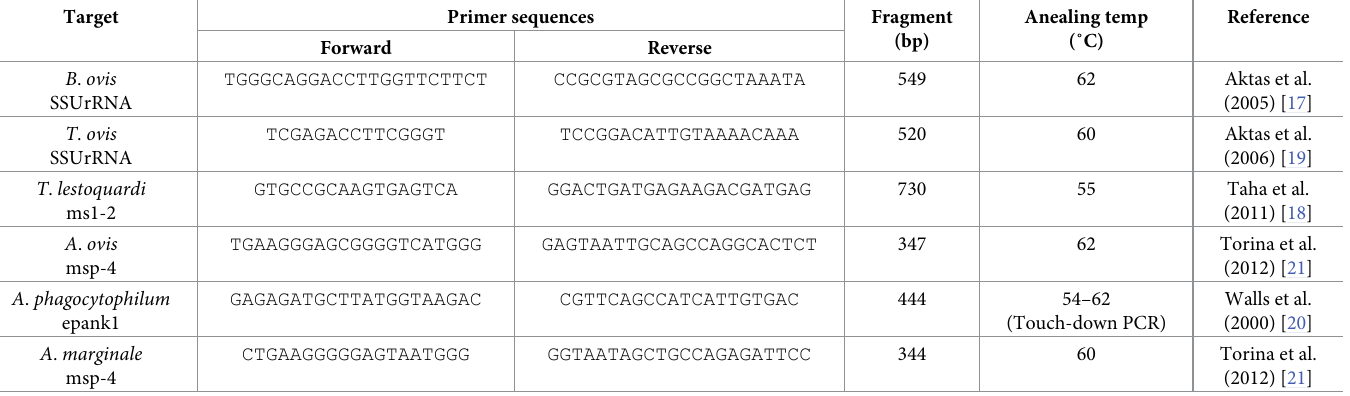
Table 1. List of primers used in this